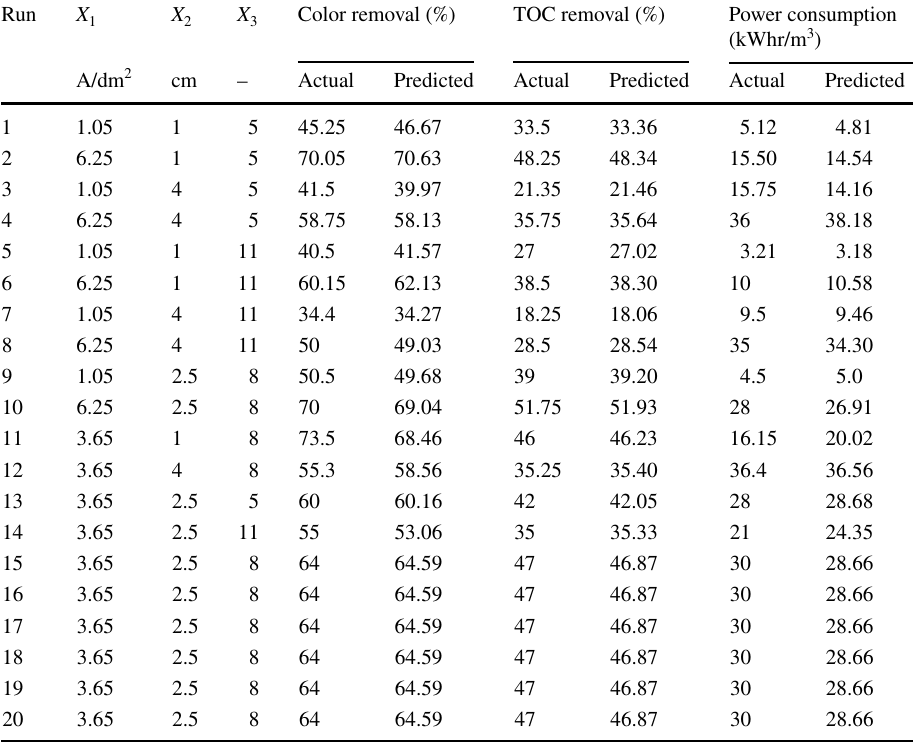
Table 3 Experimental design matrix and response based on the experimental runs and predicted values on the color removal (%), TOC removal (%) and power consumption proposed by the CCD